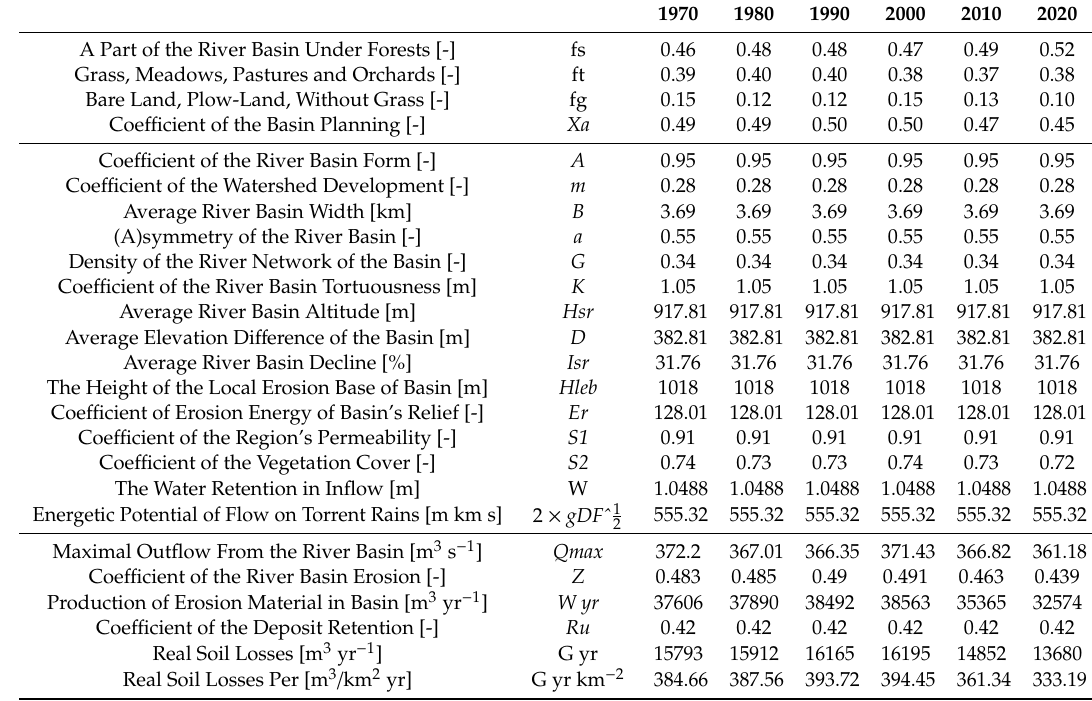
Table 6. The results of the IntErO model with the highlights on the impact of land use changes on soil erosion intensity in the Miocki Potok, Bijelo Polje Region, Polimlje,